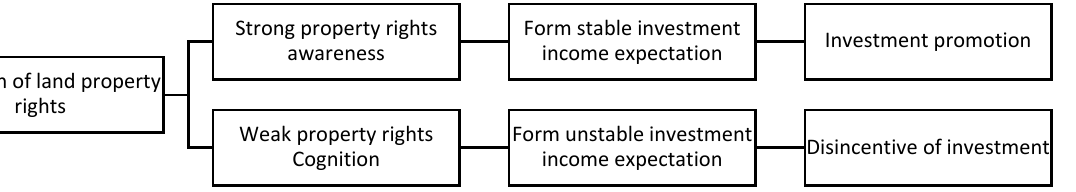
Figure 1. Theoretical framework of the impact of land property rights security cognition on farmland protection investment.